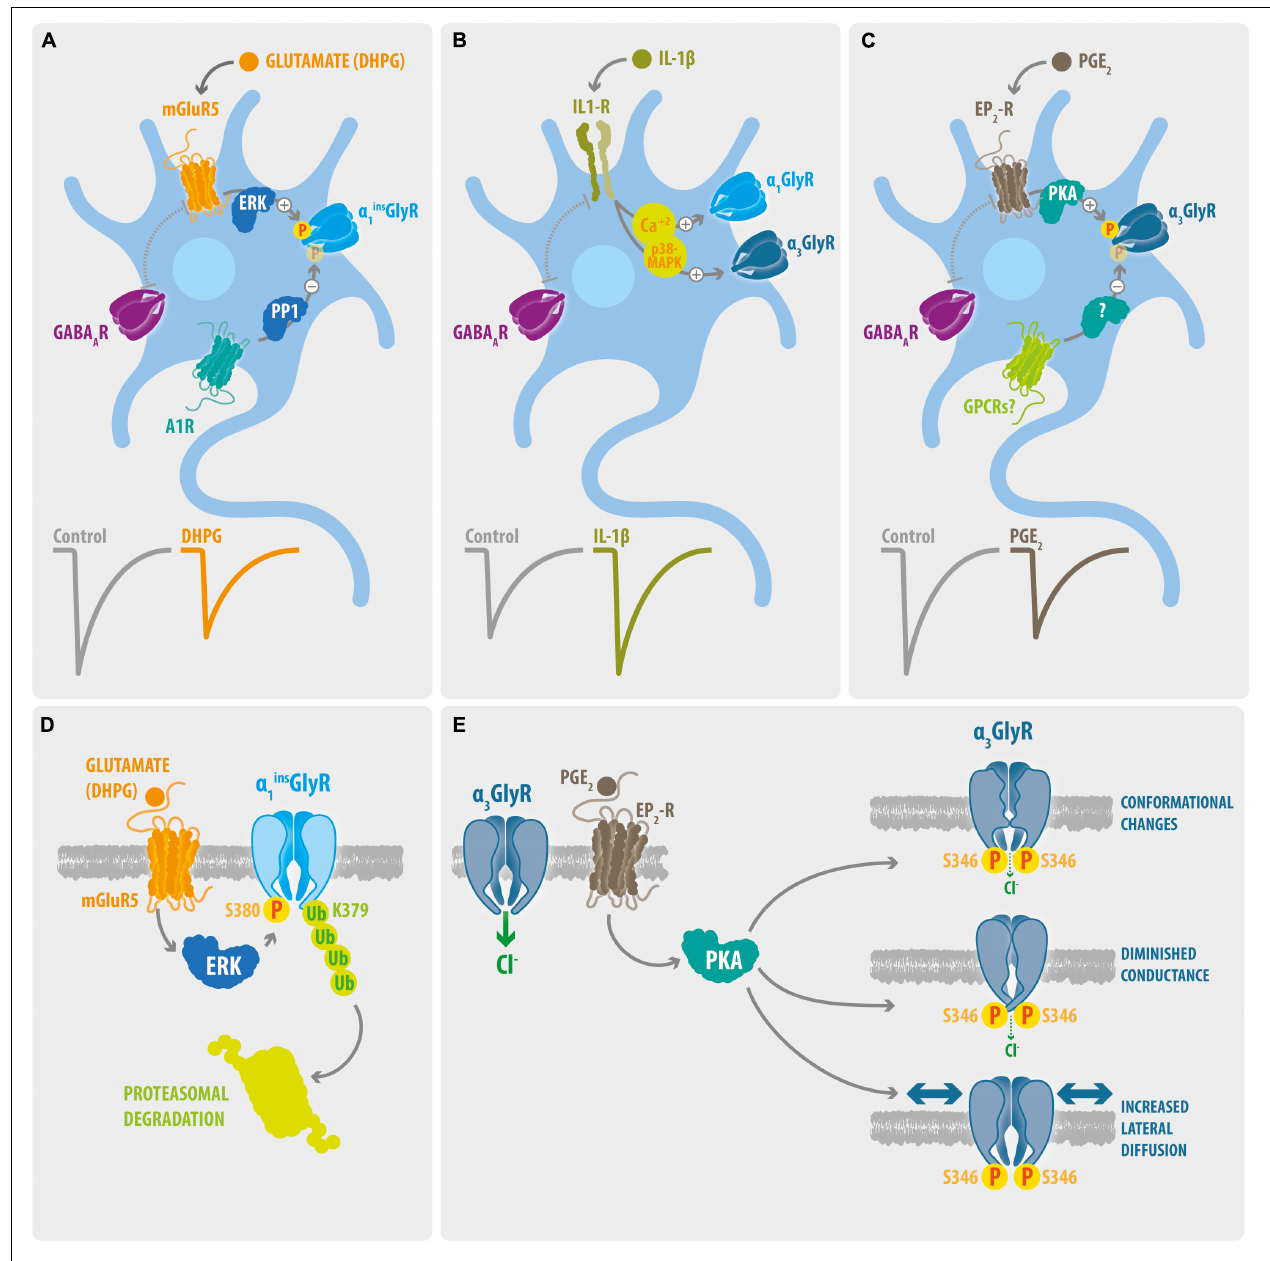
FIGURE 1 | Signaling pathways and molecular mechanisms involved on processes of glycinergic disinhibition in chronic pain. (A) Phosphorylation of dorsal horn GlyRs containing the α 1 ins subunit . The activation of mGluR5 triggers the ERK-dependent phosphorylation of synaptic α 1 ins GlyRs. On the other hand, activation of the A1Rs promotes its PP1-mediated de-phosphorylation. Activation of mGluR5 signaling with DHPG decreases the amplitude of Gly-IPSCs, whereas GABA-IPSCs were not affected. (B) IL-1 β potentiation of glycinergic synapses. The IL-1 β mediated activation of IL1-R generates a long-term potentiation of the Gly-IPSCs on dorsal horn GABAergic neurons. The glycinergic potentiation involves increases on intracellular Ca 2 + and p38-MAPK activity. The IL-1 β signaling did not affect the GABA-IPSCs. Whether this mechanism preferentially target synaptic α 1 or α 3-containing GlyRs is unknown. (C) Phosphorylation of dorsal horn GlyRs containing the α 3 subunit . Activation of EP2-R by PGE 2 decreases the Gly-IPSCs on dorsal horn neurons through the PKA-mediated phosphorylation of synaptic α 3 GlyRs. The stimulation of EP2-R did not modify the GABA-IPSCs. The molecular identity of potential GPCRs involved in the de-phosphorylation of dorsal horn α 3GlyRs remains undetermined. (D) Molecular mechanisms underlying the mGluR5-mediated glycinergic dis-inhibition . Activation of mGluR5 stimulate the binding of ERK to a consensus site located on the splice cassette ( 380 SPMLNLPQ) within the ICD of α 1 ins GlyR. ERK targets and phosphorylate the S380 residue and stimulate the subsequent ubiquitination of the L379 residue through the E3 ubiquitin ligase HUWE, triggering the proteasomal degradation of α 1 ins GlyRs. (E) Molecular mechanisms underlying the EP2-R mediated glycinergic dis-inhibition . Activation of EP2-Rs triggers the PKA-dependent phosphorylation of S346 of α 3GlyRs, leading to alterations on the ion channel function and to enhanced lateral mobility of the